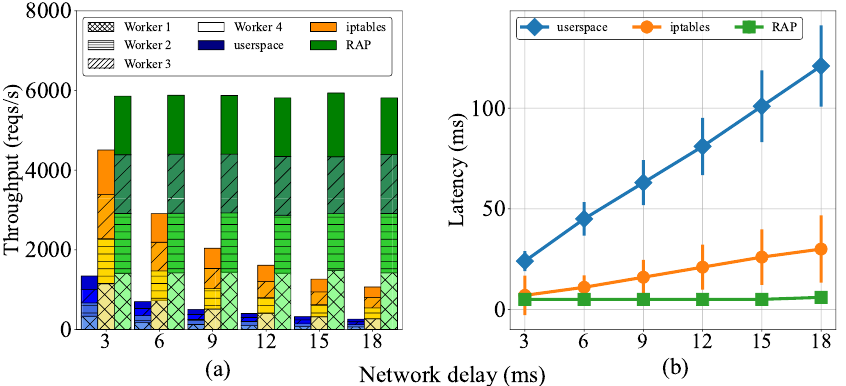
Figure 6. Cluster performance according to the network delay between workers: ( a ) throughput and ( b )